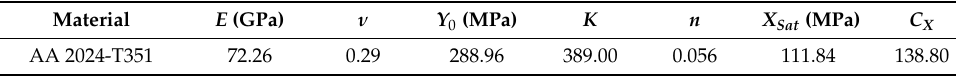
Table 1. Elastic properties of 2024-T351 aluminium alloy and parameters for the Swift isotropic hardening law combined with the Armstrong–Frederick kinematic hardening law.